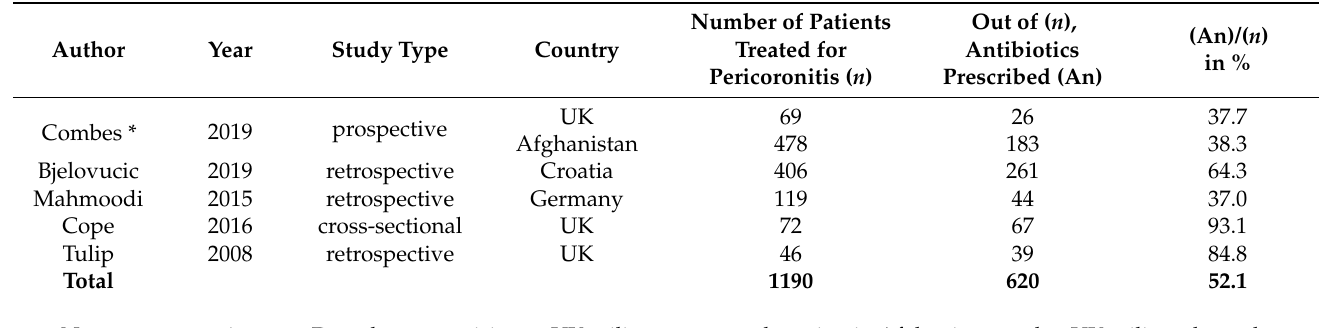
Table 10. Antibiotic prescription for patients with pericoronitis.